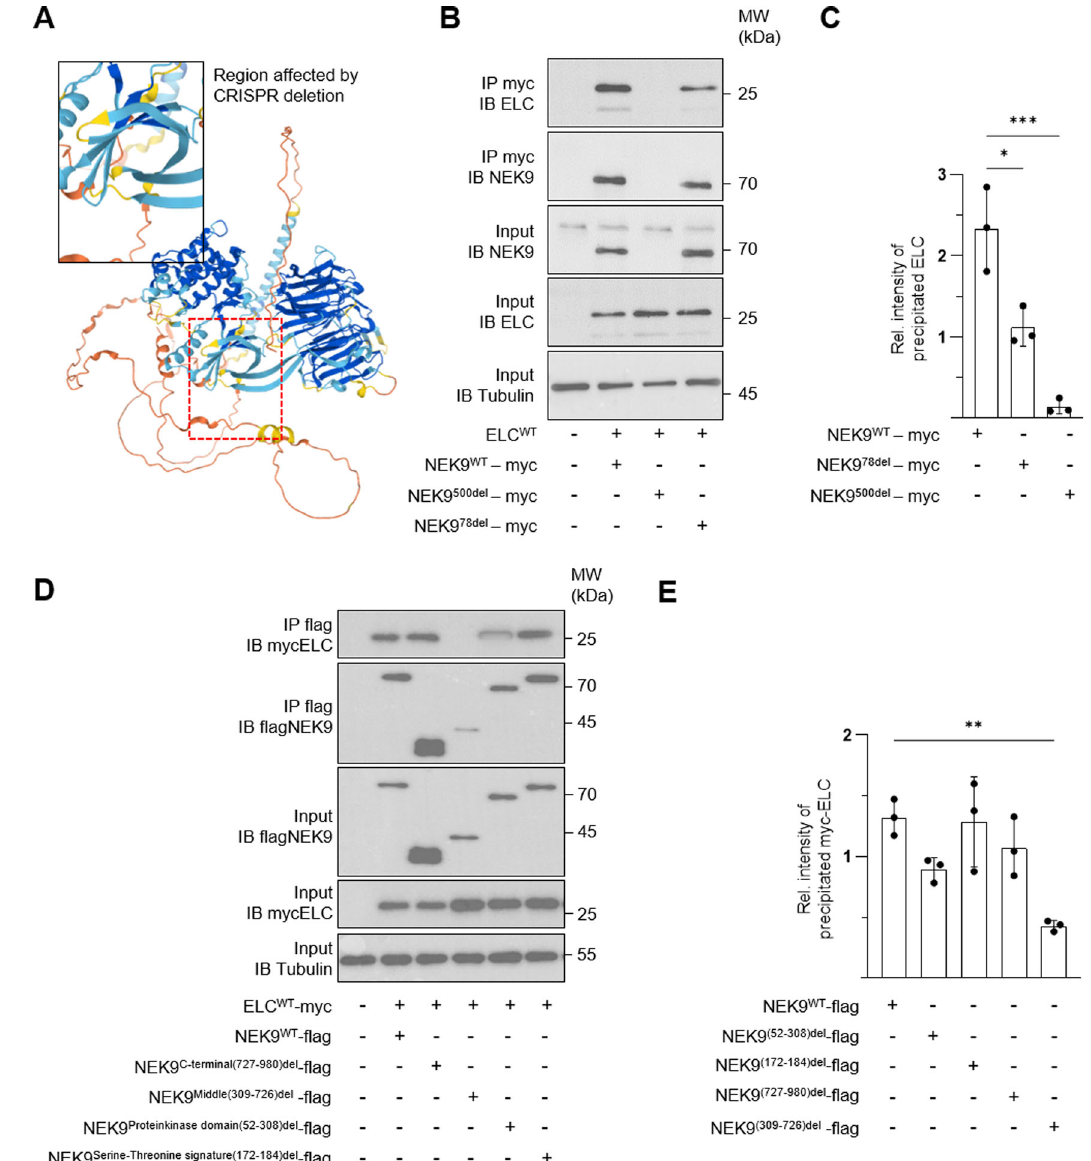
Fig. 5 | Analysis of the ELC-NEK9 interaction. Two heterozygous transgenic zebra fi sh lines were generated by CRISPR/Cas9. A NEK9 78del protein is lacking the ATP-bindingdomainshowninthe3DstructureofNEK9( A ).NEK9 500del isharboring a frame shift mutation leading to a premature stop codon. Sanger sequencing results of the affected allele are shown in Supplementary Fig. 5C. B , C Piscine ELC and mutated piscine myc-tagged NEK9 protein either lacking the ATP-binding domain (NEK9 78del ) or harboring a premature stop codon (NEK9 500del ) were over- expressed in HEK293 cells. The ELC-NEK9 interaction was analyzed by speci fi c immunoprecipitation (IP) and immunoblot (IB) ( B ). Quanti fi cation of ELC-NEK9